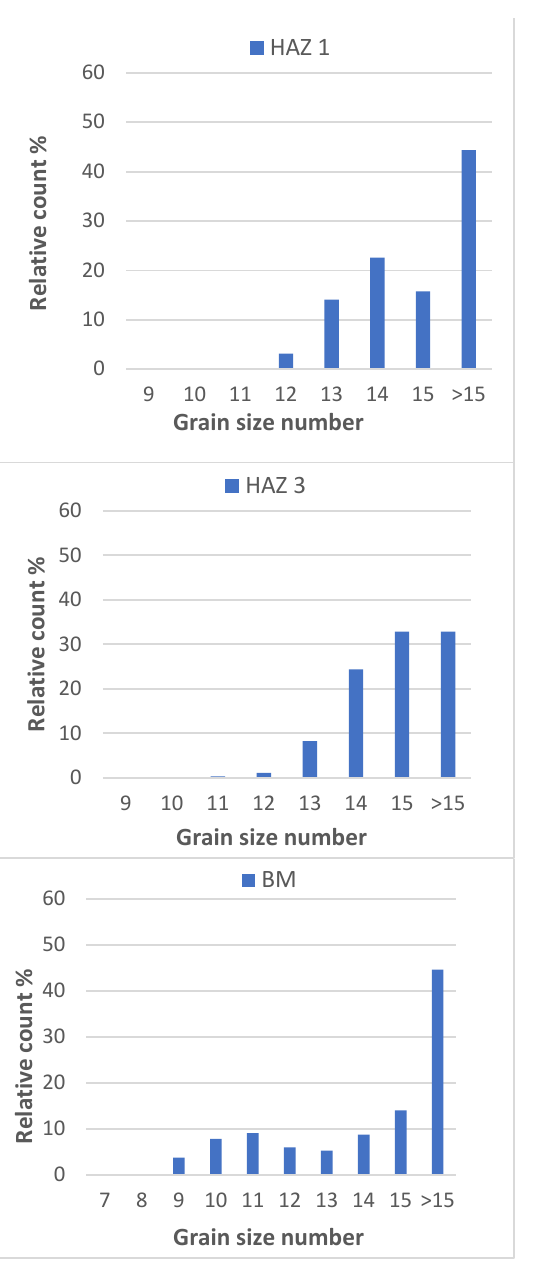
Figure 17. Percentage grain size distribution in the heat-affected zone divided into four subareas (HAZ 1 to HAZ 4) and in the base material (BM).